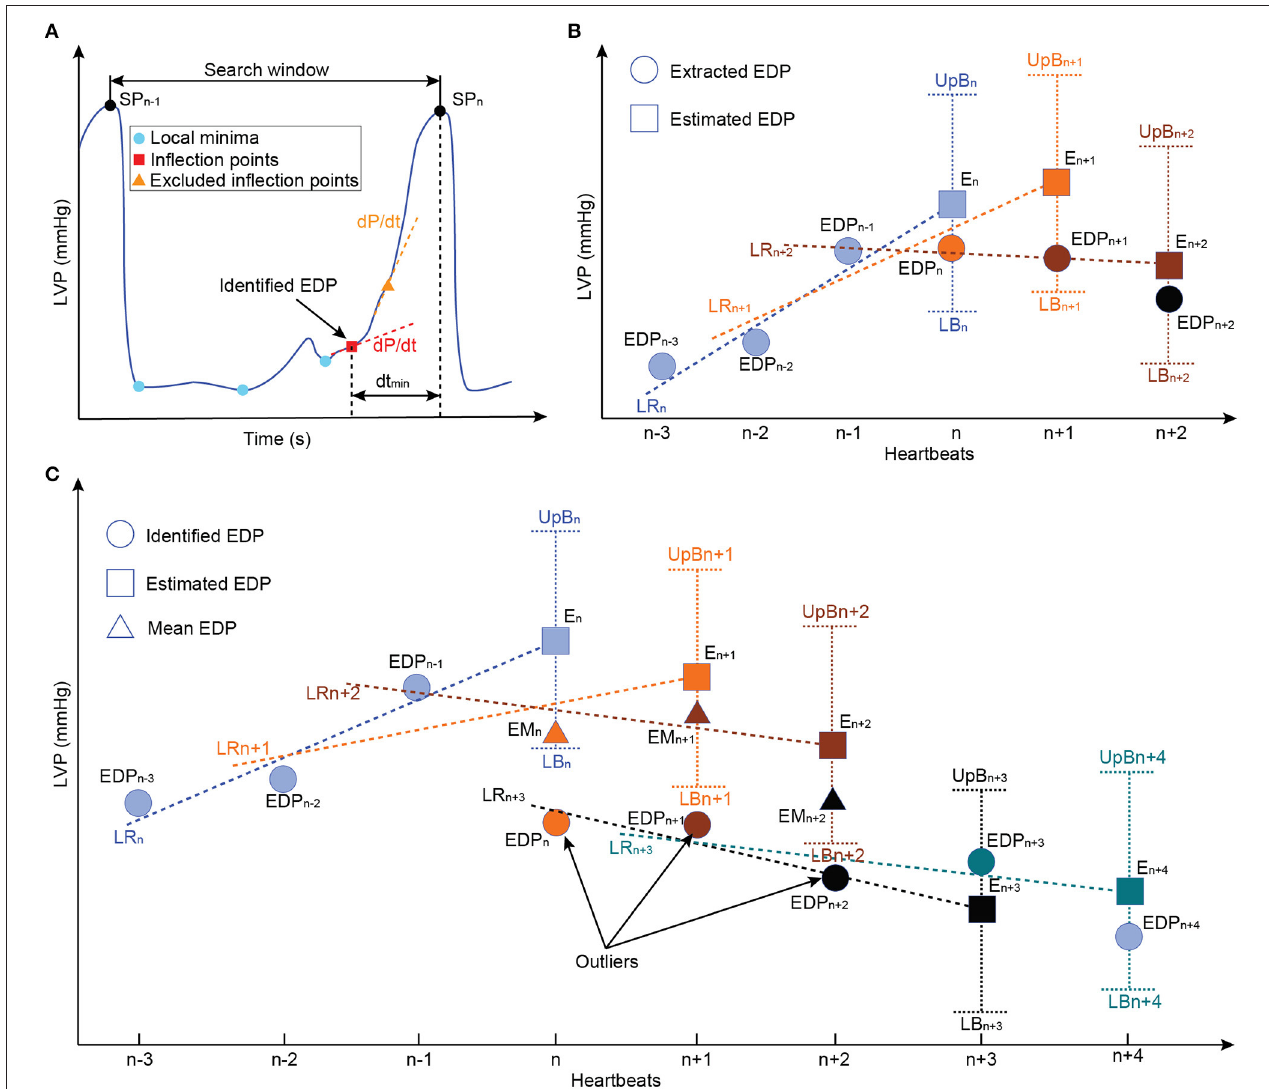
FIGURE 2 | Schematic representation of the LV-EDP extraction process and the extension for the minimization of misdetections. (A) Identification of all local minima (cyan circles) and inflection points (red rectangles) as LV-EDP candidates. The inflection points with large first LVP derivative (dLVP/dt > 40 mmHg/s) are excluded and the candidate with the smaller distance from the SP index (dt min ) is identified as the LV-EDP. (B) Comparison of the identified LV-EDP (filled circles) with the LV-EDP estimated (filled rectangles) based on linear regression of the LV-EDP extracted on the previous three heartbeats. If the identified LV-EDP is within the boundaries, it is extracted as LV-EDP value. (C) Based on the comparison described in b, if the identified LV-EDP is outside the boundaries it is considered an outlier and the mean value of the last three LV-EDPs is extracted as LV-EDP (filled triangles) of the investigated heartbeat. The outliers are stored in memory and if three consecutive identified LV-EDPs constitute outliners a flag is raised and the new LV-EDP estimate is based on the outliers (LR n + 3 ) instead of the extracted LV-EDPs. In this way, physiological rapid changes in preload are not obscured. LVP, left ventricular pressure; EDP, end-diastolic pressure; LR, linear regression; EM, extracted mean value; E, extracted; UpB, upper boundary; LB, lower